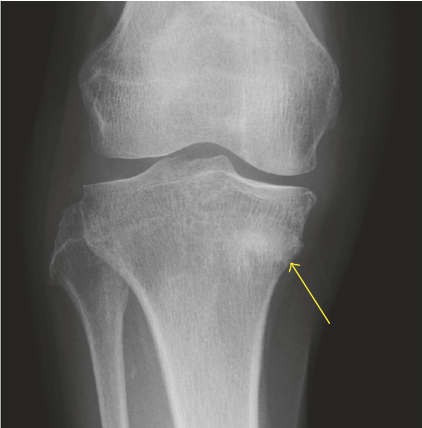
Figure 3: The anteroposterior radiograph of right knee 4 months after the onset showing the bone union of the insufficiency fracture (yellow